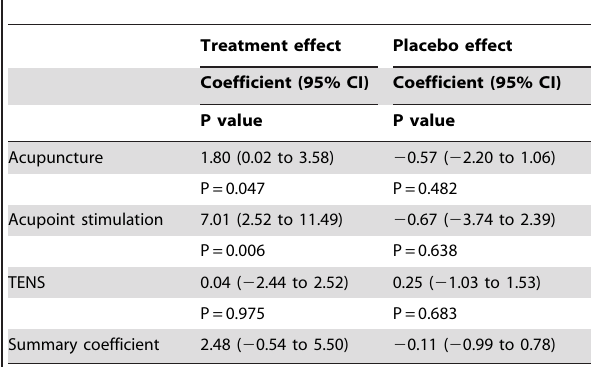
size, and the simulated effect sizes for data from non-parametric trim and fill analysis. For the treatment effect (Figure 4A and B), the effect sizes combined over eligible trials were greater than those predicted for hypothetical trials with infinite size or those simulated on data from nonparametric trim and fill analysis. For Table 2. Asymmetry coefficients.